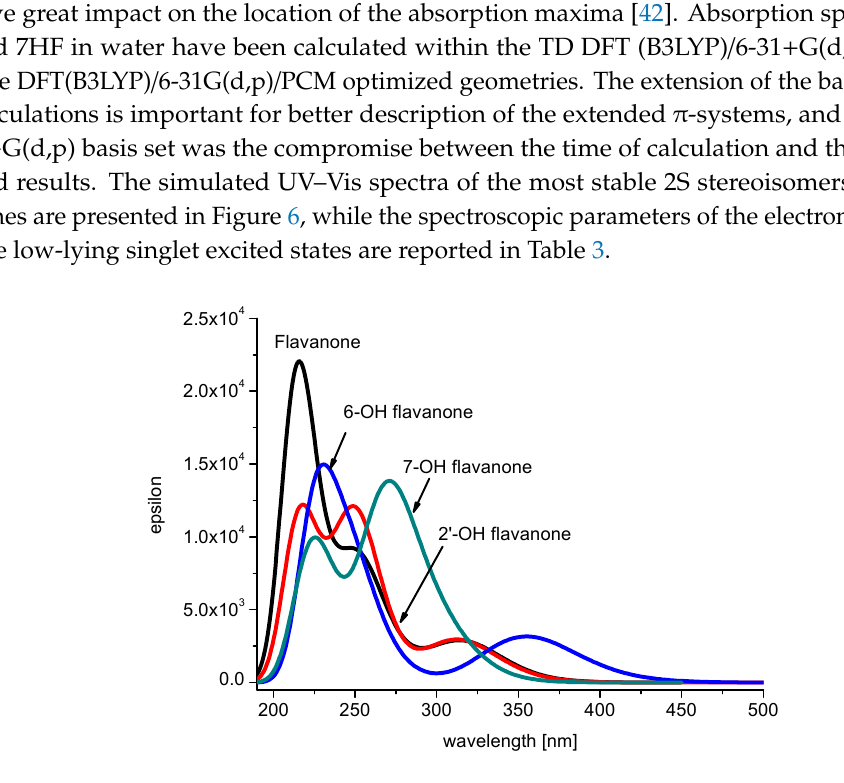
Figure 6. The simulated UV–Vis spectra of the 2S flavanones: flavanone, 6-hydroxyflavanone, 7-hydroxyflavanone and 2’-hydroxyflavanone. (Gaussian 09 and GaussView 5.0.8 Origin(Pro) software). Table 3. The TD (nstates = 10) DFT(B3LYP)/6-31+G(d,p)/PCM calculated spectroscopic parameters (transition electric dipole moment ( μ ); wavelength corresponding to the excitation energy ( λ ) and oscillator strength (f)) of the electronic transitions to the three low-lying excited singlet states of 2S stereoisomers of F, 2’HF, 6HF and 7HF.